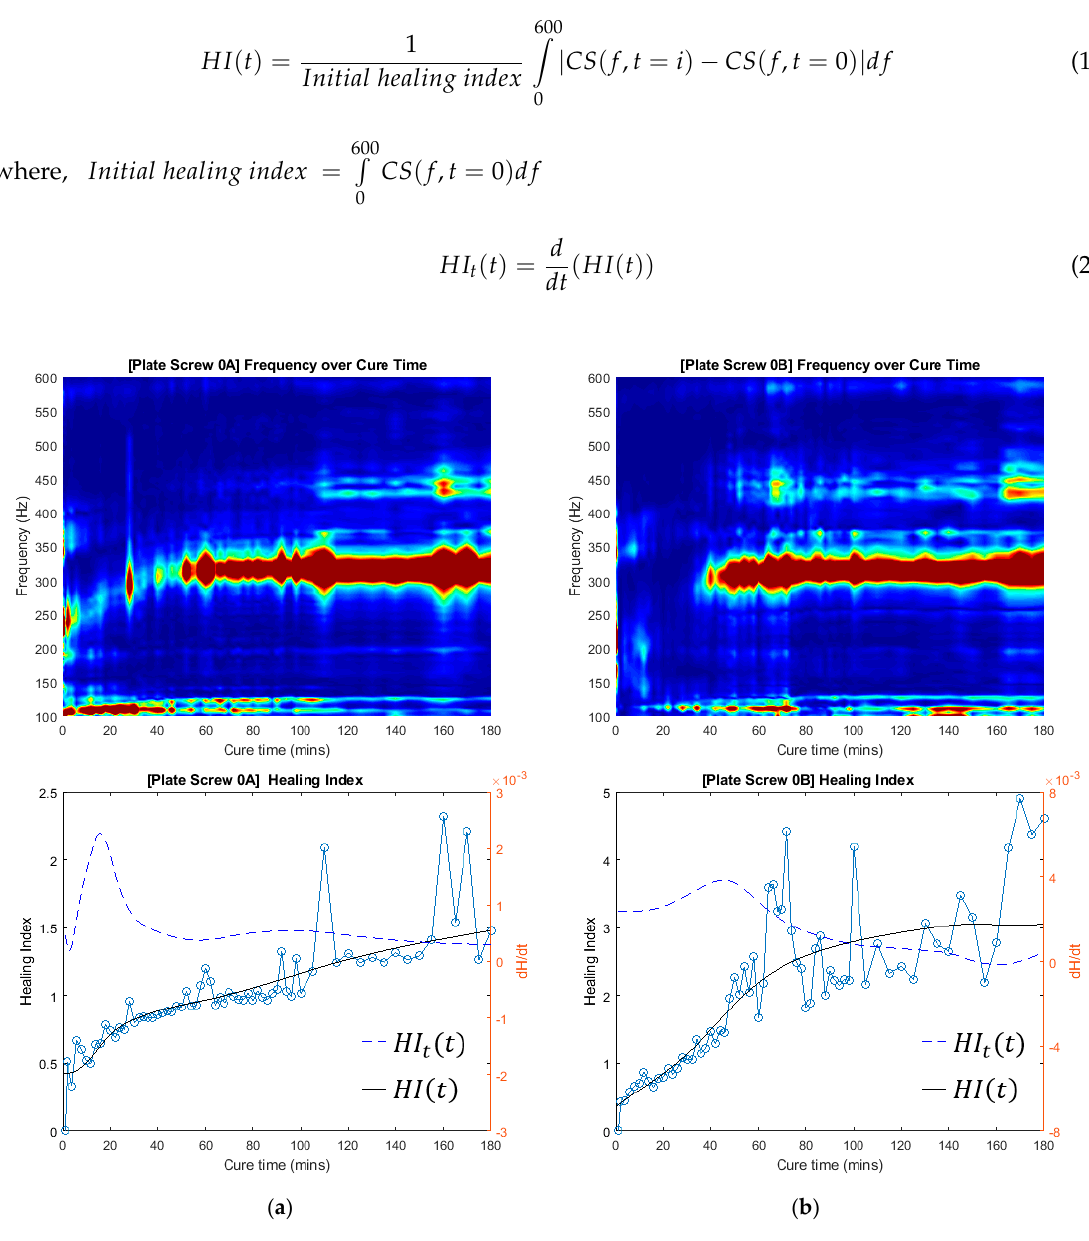
Figure 10. Frequency over cure time and Healing Index of two experimental investigations with no mass damping. ( a ) Test #0A; ( b ) Test #0B.